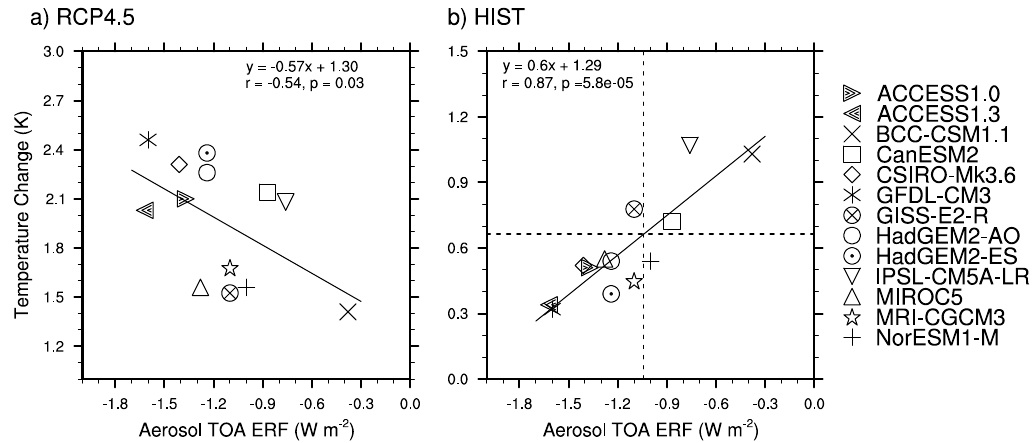
Fig. 10. Changes in global-mean surface-air temperature from CMIP5 models plotted against (2000 relative to 1850) global-mean aerosol ERF diagnosed from fixed-SST simulations: (a) RCP4.5 (2006–2100), (b) historical simulations (1850–2005). CMIP5 models are listed in Table 1. Temperature changes are calculated from least-squares trends. Also shown in each panel are the regression line, the equation for the regression line, the correlation and the level of significance. The dashed horizontal line in (b) shows the observed 1850–2005 warming from HadCRUT4, and the dashed vertical line shows the “top-down” estimate of aerosol ERF implied by the intersection of the horizontal line with the regression